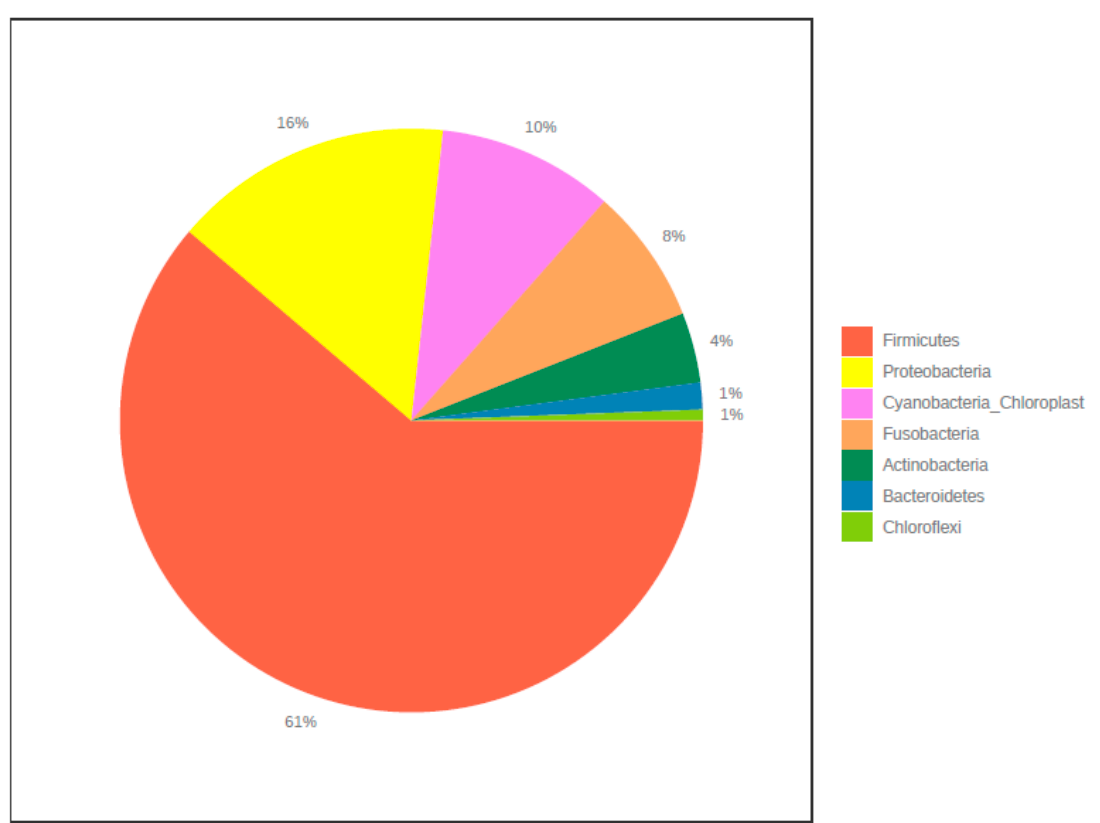
Figure 2. Microbiome composition of all samples at phylum level.